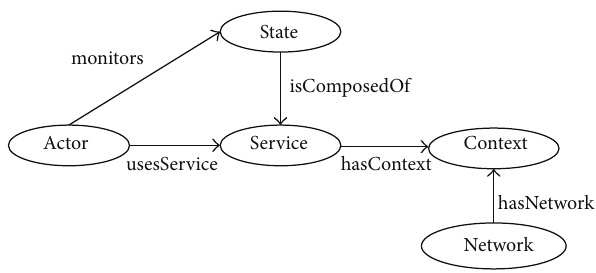
Figure 5: Top level ontology model of logistics